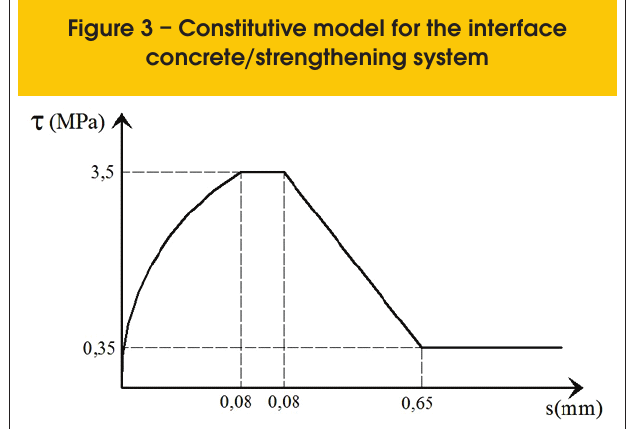
Figure 3 – Constitutive model for the